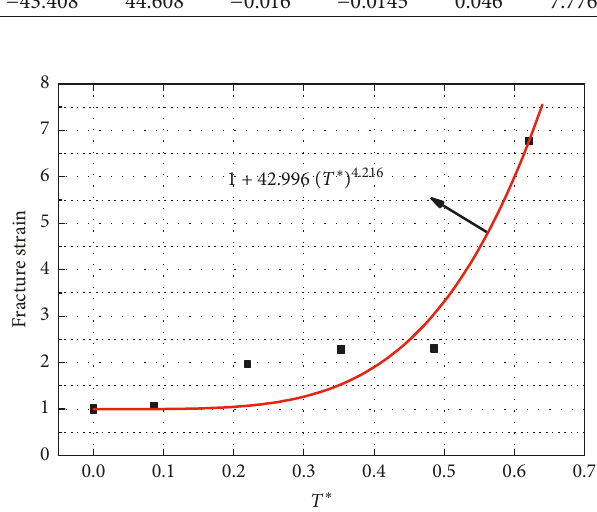
Figure 13: Fracture strain at different temperatures. Table 6: Numerical simulation results of Case 1 and Case